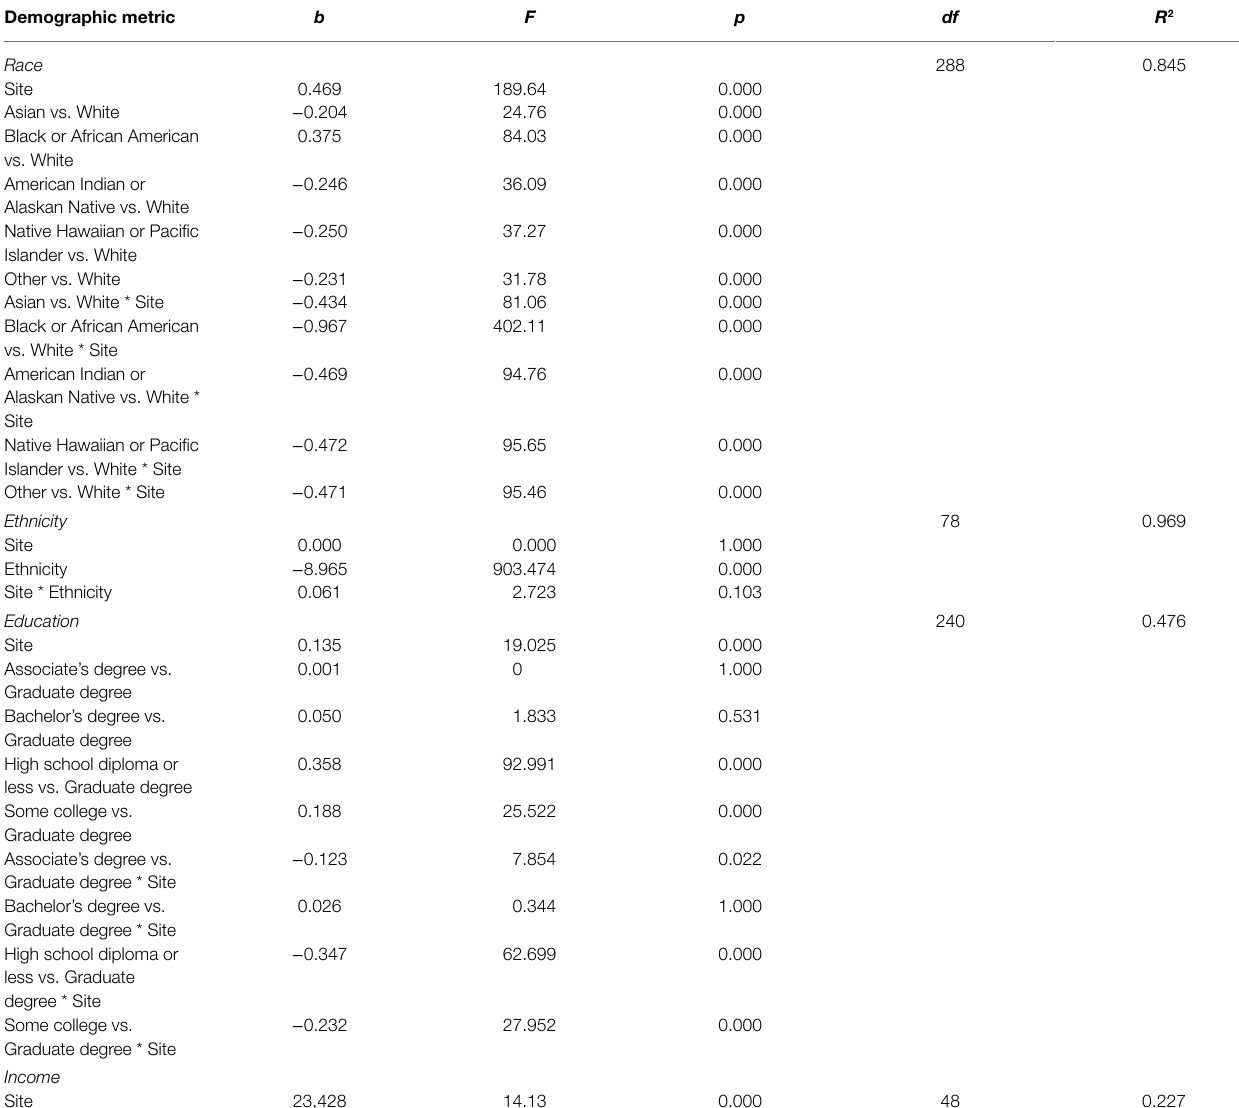
TABLE 4 | Results of regression analyses by demographic metric. Demographic